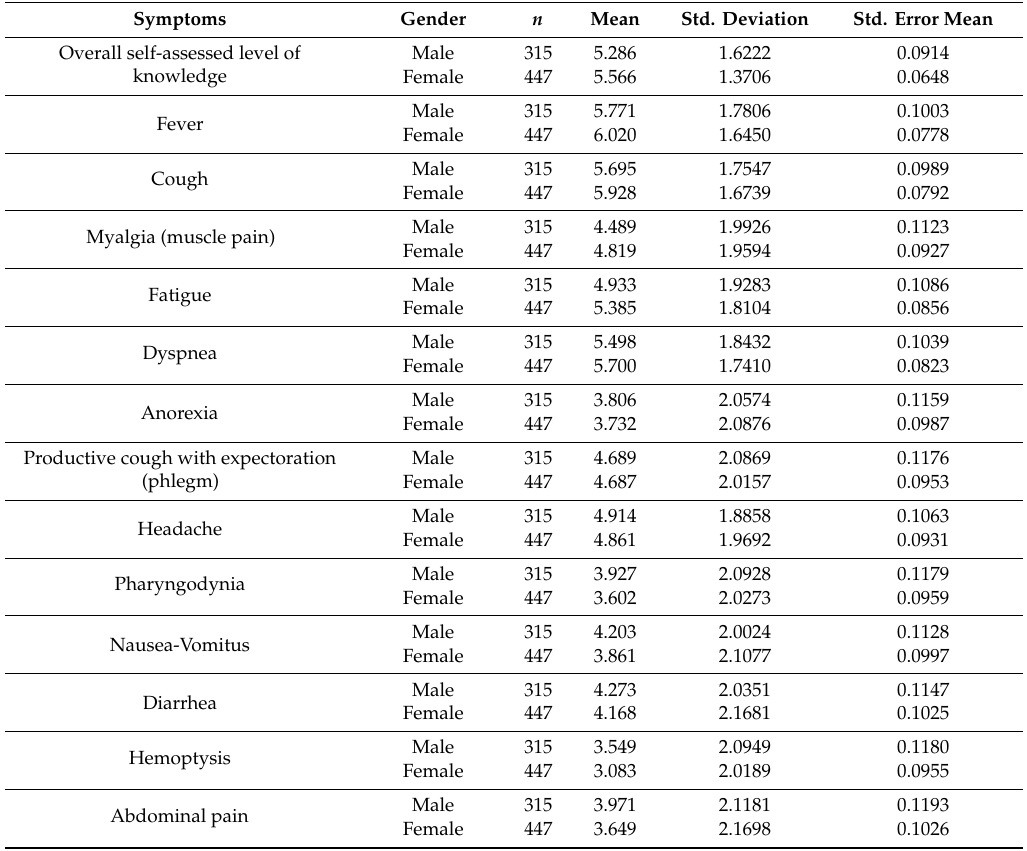
Table 5. Group statistics of gender and self-assessed knowledge of COVID-19 symptoms.